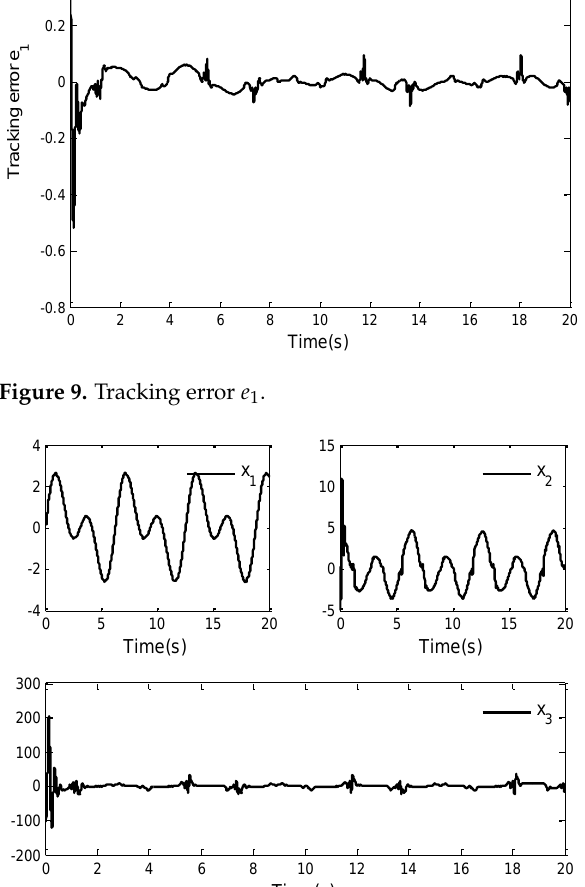
Figure 10. System states x 1 , x 2 , and x 3 .